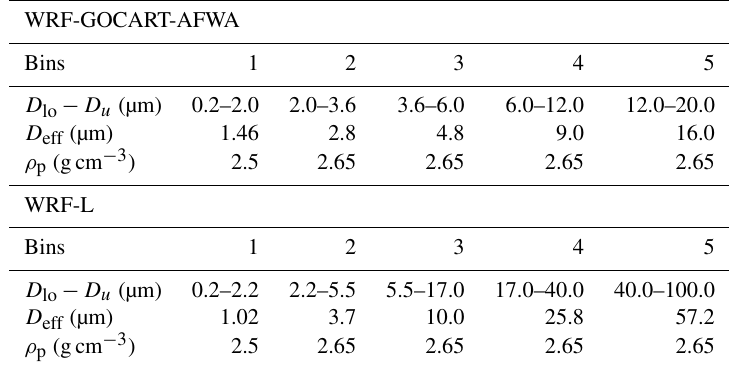
Figure 1. The structure of the presented work. Steps (1), (2) and (3) correspond to the appropriate modifications implemented in the WRF- Chem GOCART-AFWA dust scheme for the inclusion of the giant dust particles and the development of WRF-L. Step (4) refers to model validation activities. Table 1. Size ranges and properties of model size bins in the default WRF-GOCART-AFWA